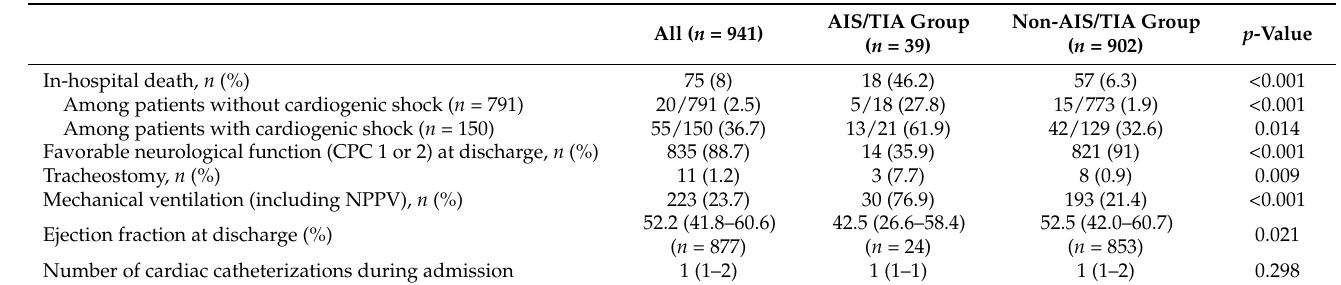
Table 3. Comparison of outcomes and clinical course between the AIS/TIA group and the non- AIS/TIA group.